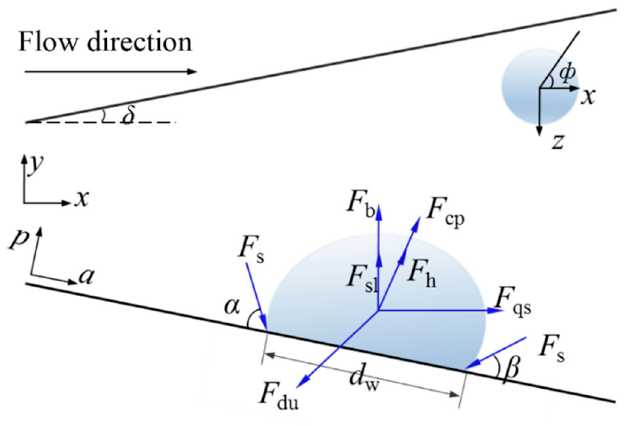
Figure 3. Various forces during the growth stage of the bubble.